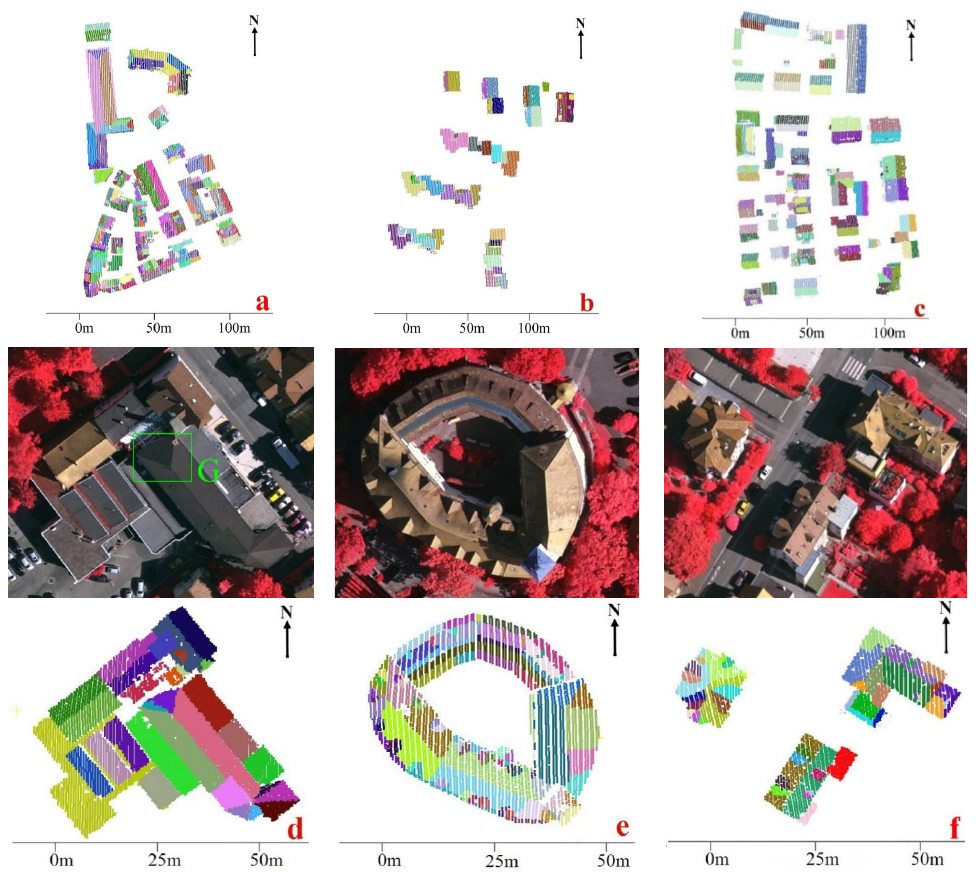
Figure 10. Segmentation of Vaihingen data. ( a – f ) are six selected areas from the data. (top: image, bottom: results of BDSAC nv ).